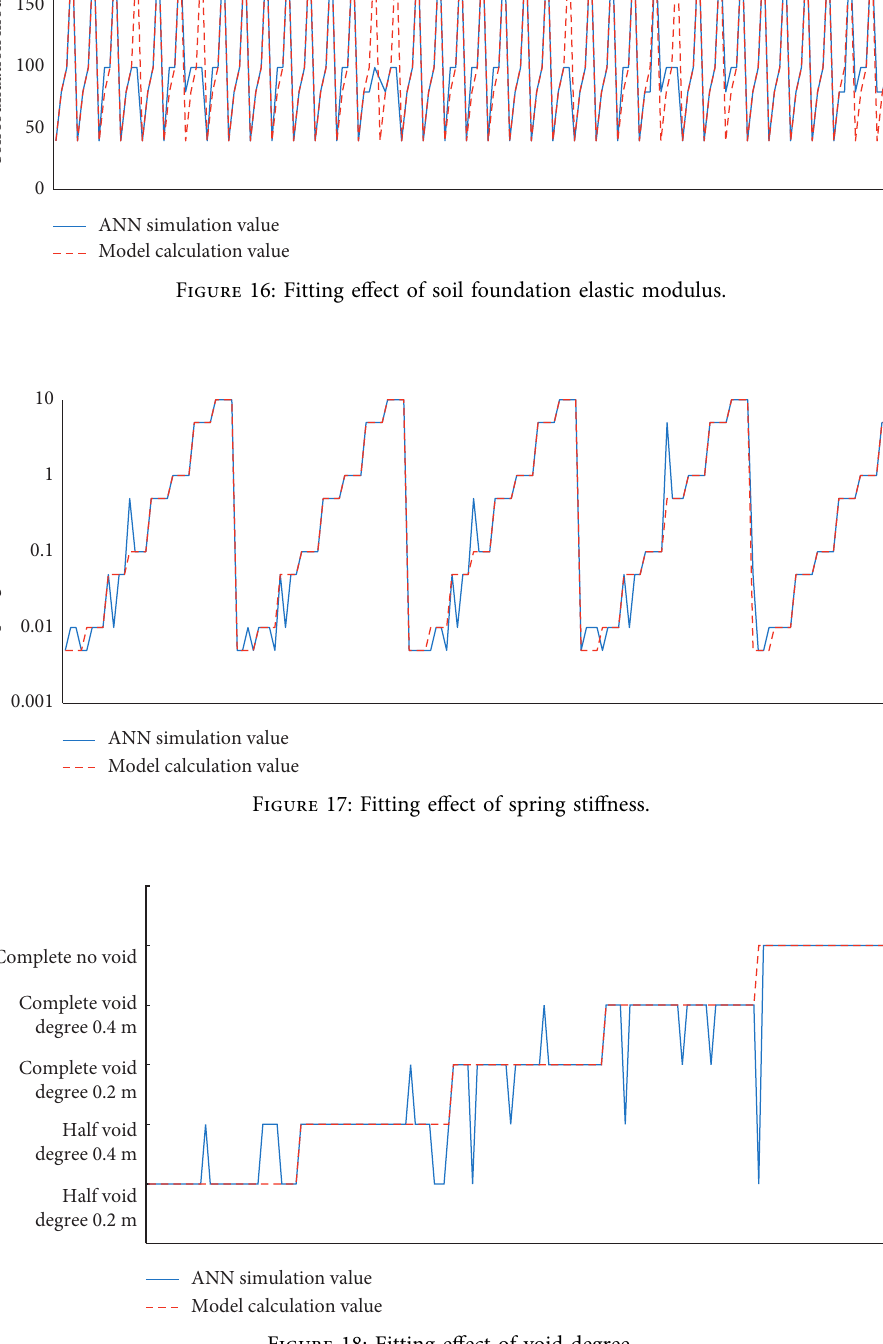
Figure 18: Fitting effect of void